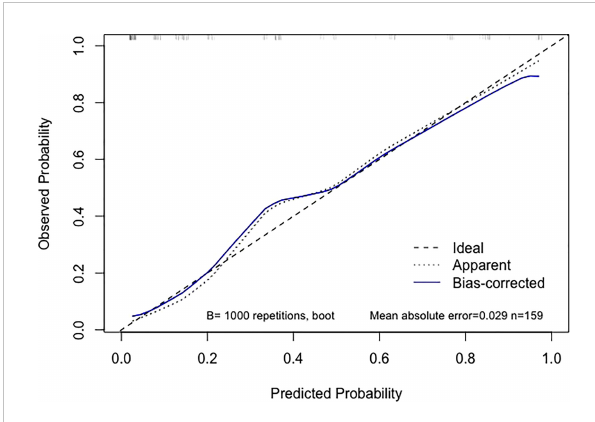
FIGURE 4 Calibration curve of the nomogram. When the solid line (representing the nomogram) was closer to the the dotted line ( “ Ideal ” , representing an ideal model), the predictive performance of the nomogram was better.